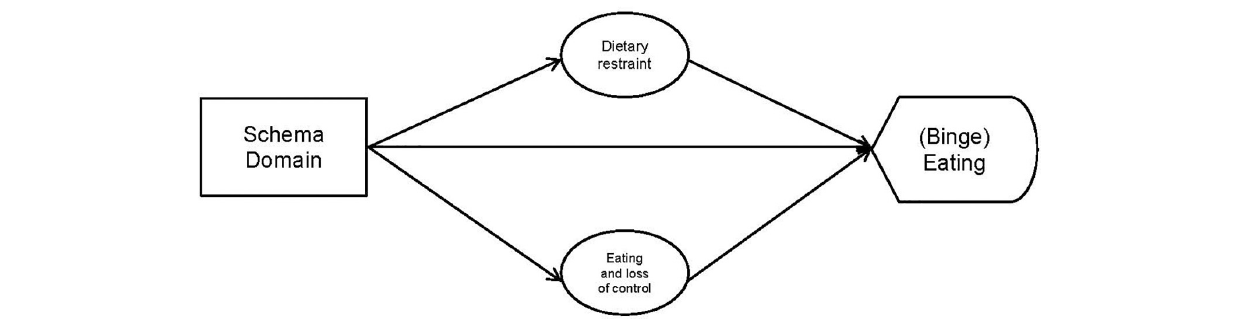
FIGURE 1 | Assumed associations between schema domains, cognitive content and binge